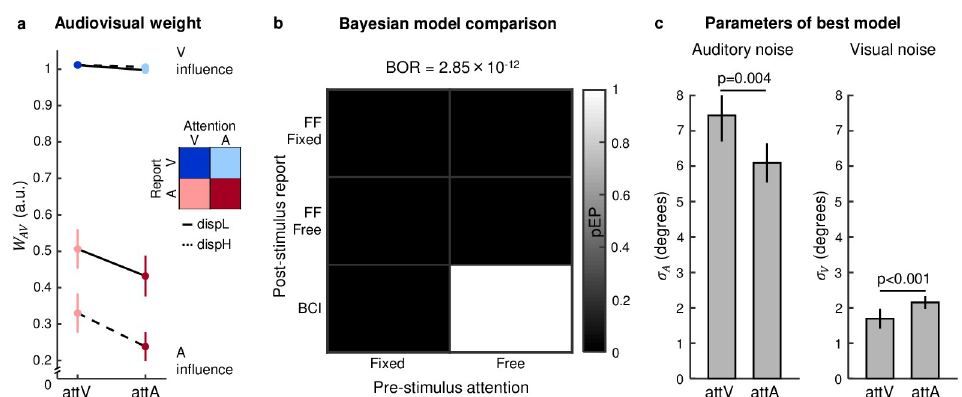
Fig 3. Audiovisual weight index ( w ) and Bayesian modelling results for the fMRI experiment. (a) Across AV participants’ mean w AV ( ± SEM) shown as a function of (i) prestimulus attention: auditory attA versus visual attV; (ii) poststimulus report: auditory repA versus visual repV; and (iii) AV spatial disparity: low dispL (9˚) versus high dispH (18˚). w = 1 for purely visual and w = 0 for purely auditory influence. (b) Along the first factor of a 2 × 3 factorial AV AV model space, we assessed the influence of prestimulus attention by comparing whether the sensory variances were (i) constant (fixed: s 2 = s 2 , s 2 = s 2 ); or (ii) different (free: s 2 , s 2 , s 2 , s 2 ) across prestimulus A attA A attV V attA V attV A attA A attV V attA V attV attention. Along the second factor, we assessed the influence of poststimulus report by comparing (i) a forced fusion model in which the sensory variances were fixed (FF fixed: s 2 = s 2 , s 2 = s 2 ); (ii) a forced fusion model A repA A repV V repA V repV , s 2 , s 2 , in which the sensory variances were allowed to differ between auditory and visual report (FF free: s 2 A repA A repV V repA ); and (iii) a BCI model in which the influence of poststimulus report arises via a late flexible readout. The matrix s 2 V repV represents our 2 × 3 model space. For each model, we show the pEP (larger pEP represents better model) via greyscale. BOR represents the probability that results are due to chance. (c) Across participants’ mean ( ± SEM) of auditory and visual noise parameter estimates (i.e., s 2 , s 2 , s 2 , s 2 ) of the best model, i.e., BCI model with free A attA A attV V attA V attV prestimulus attention parameters (attA, auditory; attV, visual). p -Values based on one-tailed sign permutation test. The data used to make this figure are available in S2 Data. BCI, Bayesian causal inference; BOR, Bayesian omnibus risk; FF, Forced Fusion; pEP, protected exceedance